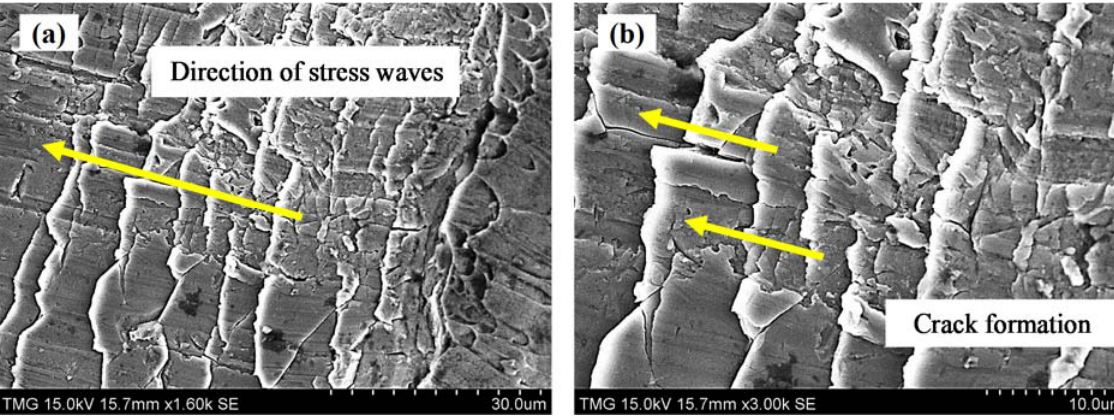
Figure 23. Direction of stress waves and crack formation on the surface of DR-treated specimens at the initial stages of LIE